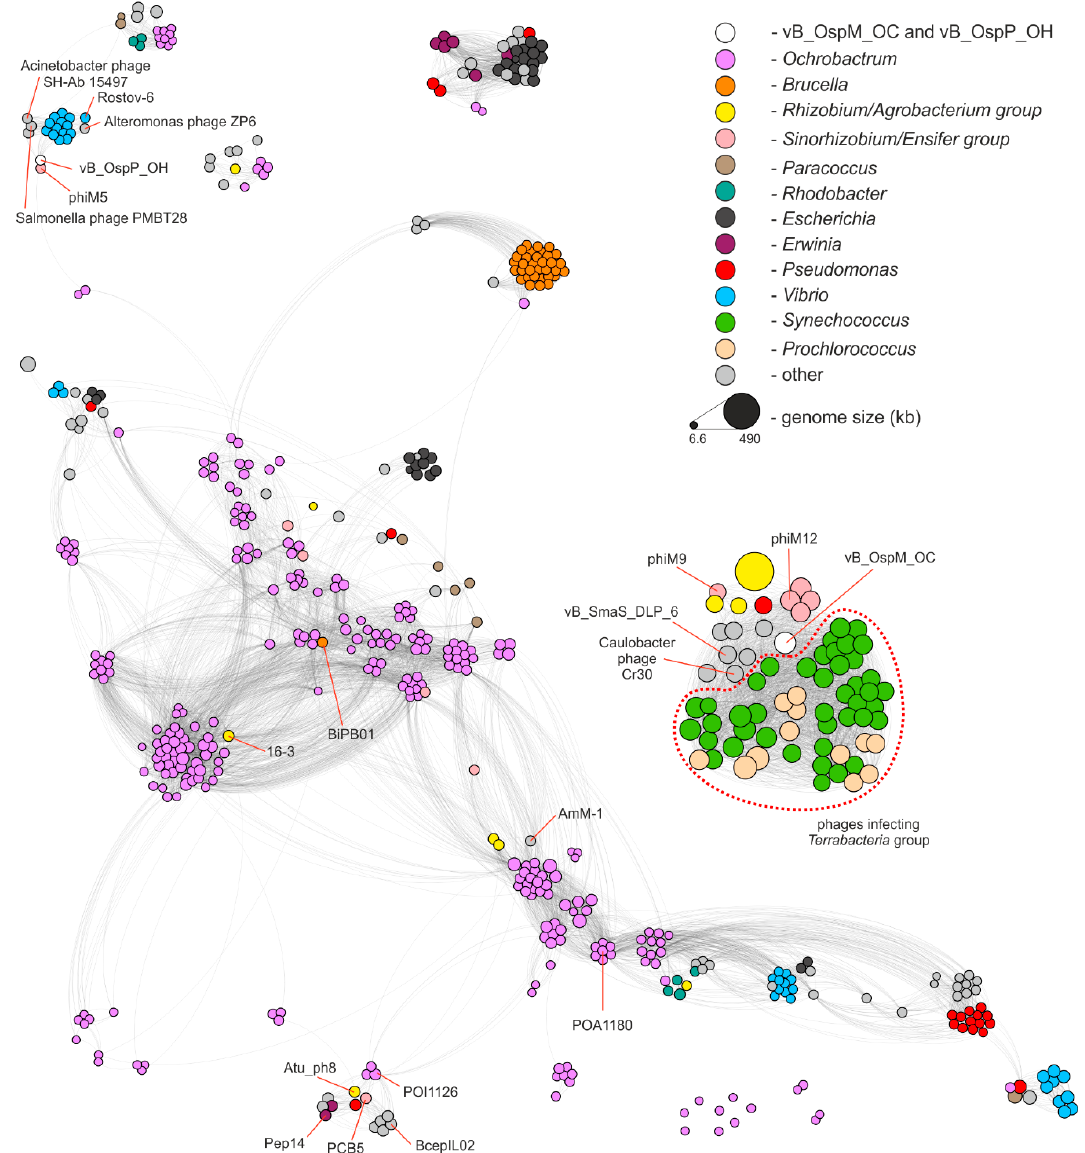
Figure 3. Protein-based similarity network of Ochrobactrum (pro)phages to the other selected phages. Within the network, constructed with vConTACT v2 and visualized in Gephi, each node (575 in total) represents a (pro)phage, and each edge (9622) corresponds to the vConTACT’s degree of similarity between the two phages. The size of the nodes reflects the size of the (pro)phage genome, and its color corresponds to the host genus (if at least five viruses infected by the same genus were included in the network). Nodes representing the vB_OspM_OC and vB_OspP_OH phages are presented in white. If less than five phages were included in the network, they were presented in a joint category called “other”; these were phages infecting Ralstonia , Burkholderia , Stenotrophomonas , Wolbachia , Achromobacter , Sulfitobacter , Pasteurella , Enterobacter , Klebsiella , Shigella , Roseobacter , Salmonella , Rhodovulum , Thiobacimonas , Xantomonas , Pelagibacter , Dinoroseobacter , Mesorhizobium , Cystobacterineae , Alteromonas , Acidithiobacillus , Azospirillum , Alteromonadaceae , Serratia , Delftia , Acinetobacter , Aurantimonas , Enterobacteria , Caulobacter , Acidovorax , and Bradyrhizobium . Additionally, the phages infecting the Terrabacteria group were distinguished with a dotted line.